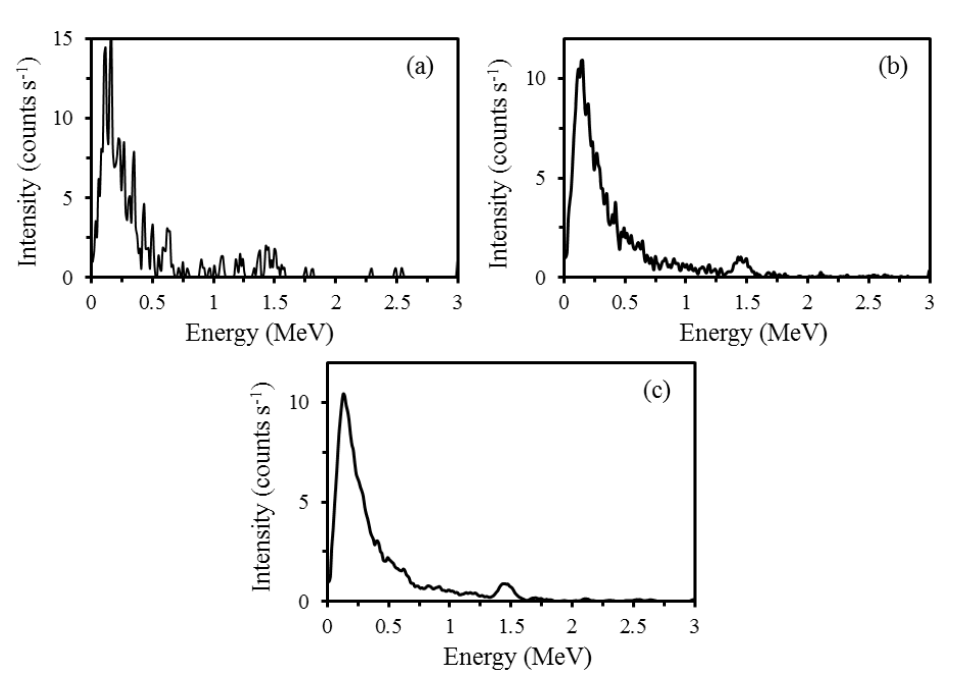
Figure 3. Examples of ( a ) a raw gamma-ray spectrum measured every second; ( b ) moving average of seven spatial spectra in a row and ( c ) moving average of five channels within a spectrum.